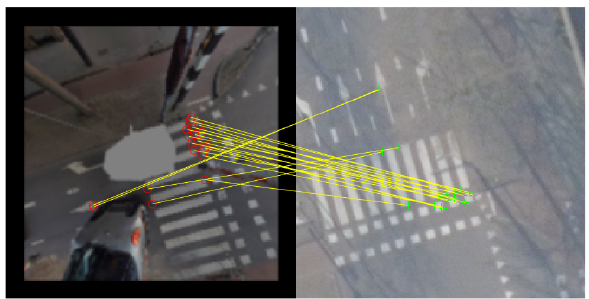
Figure 7. Test area 2; Although the images differ due to some occlusions, our approach could yield only correct correspondences